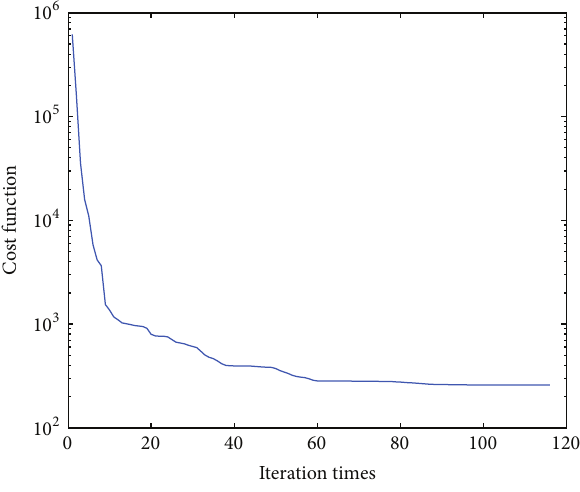
Figure 3: Surface temperature error of billet. Table 1: Determination of an optimal value stopping parameter.